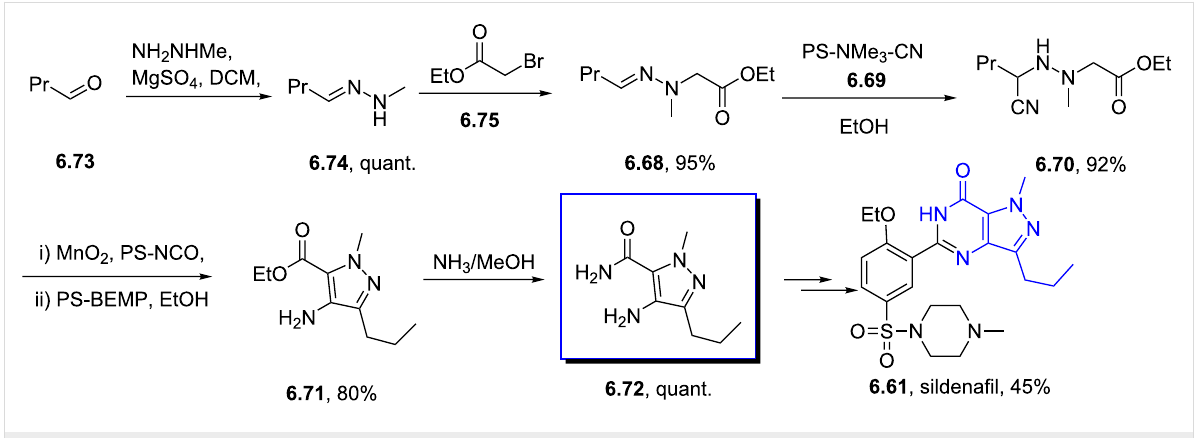
Scheme 59: Polymer-supported reagents in the synthesis of key aminopyrazole 6.72 .